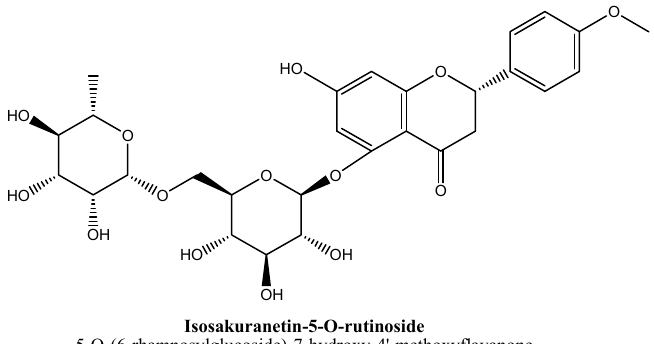
Figure 32. Isosakuranetin-5-O-rutinoside. Liquiritin is a 4 ′ -O-glucoside of the flavanone liquiritigenin, in which a β -D-glucopy- ranosyl residue is attached to liquiritigenin at position C4 ′ by a glycosidic linkage (Figure 33) and found in spices and herbs. Whereas isoliquiritin is a trans-chalcone derivative, C2 ′ and C4 ′ positions substituted with hydroxyl group and a β -D-glucopyranosyloxy moiety attached at position C4 (Figure 34). liquiritin and isoliquiritin isolated from aqueous ex- tract of roots of Glycyrrhiza uralensis Fisch. were evaluated for their anti-depressant poten- tial in mice at doses 10, 20 and 40 mg/kg using forced swim and tail suspension test [124]. Further, these flavonoids found to produce significant antidepressant effect and their pro- posed mechanism includes slowing down of 5-HT metabolism, significant reduction in 5- HIAA/5-HT ratios and increased concentration of monoamine neurotransmitters (espe- cially, serotonin and nor-epinephrine) in the cortex, hypothalamus and hippocampus of mice [124].